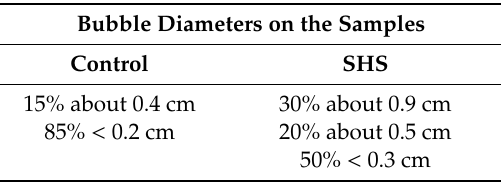
Table A1. Supporting information for Figure